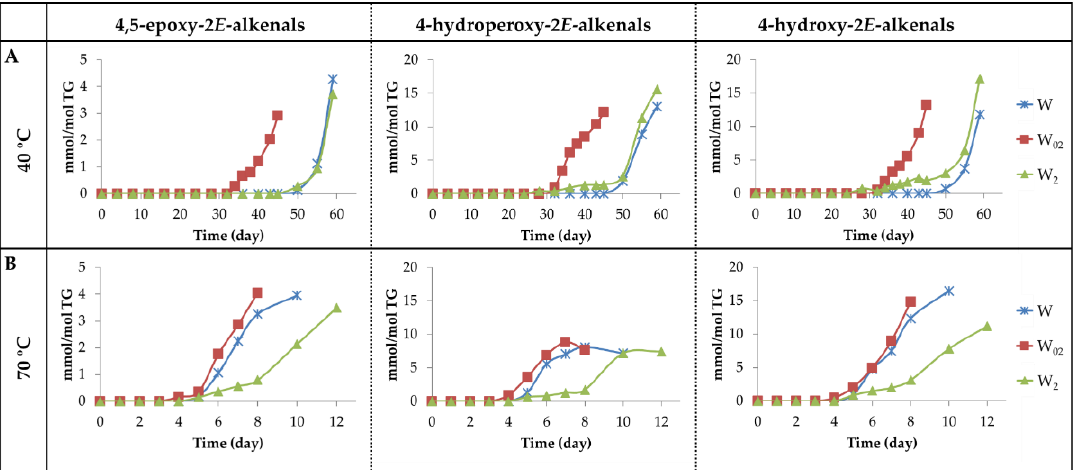
Figure 14. ( A ) Evolution of the concentration expressed as mmol/mol TG, of 4,5-EPO-2 E -alkenals, 4-HPO-2 E -alkenals and 4-HO-2 E -alkenals in walnut oil with different enrichment levels of αT (W, W 02 and W 2 ) submitted to 40 °C up to advanced stages of the oxidation process. ( B ) The same at 70 °C.